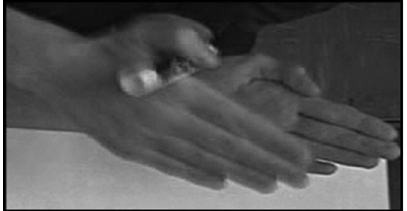
FIG. 19. Picture drawn by David.